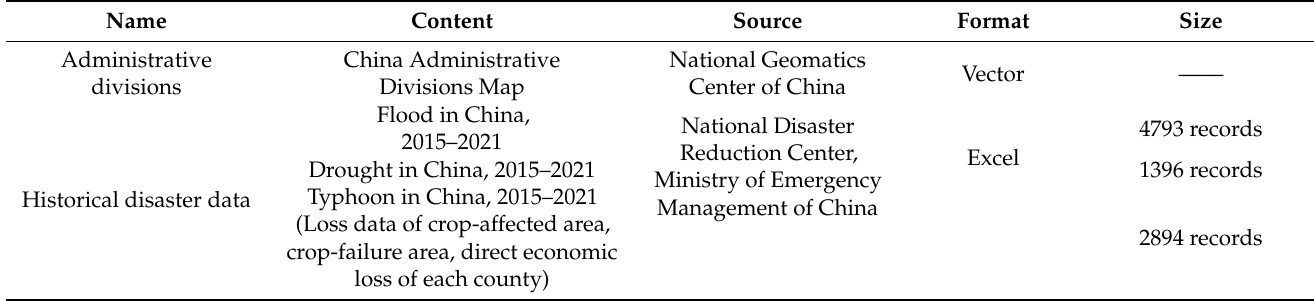
Table 1. Basic data.